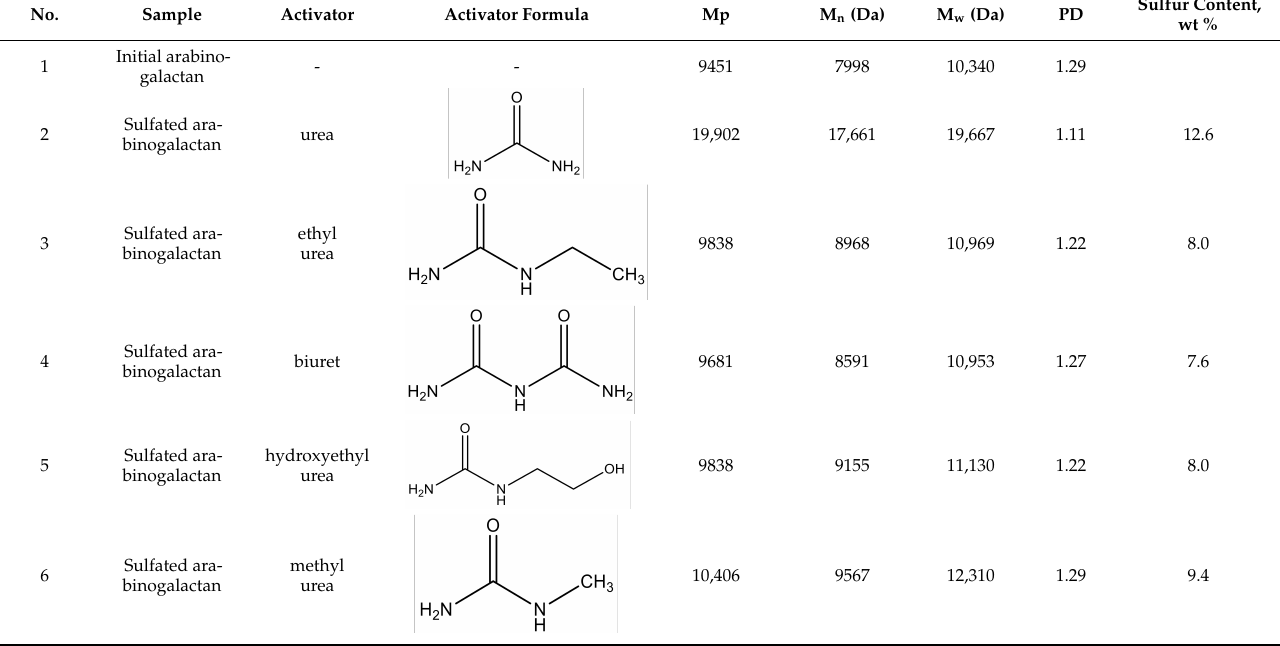
Table 1. Effect of the urea-based activators on the MWD and sulfur content in arabinogalactan sulfated with sulfamic acid in 1,4-dioxane at 85 ◦ C for 3 h, the ratio of the amount of the complex to the amount of the polysaccharide corresponds to 1:15